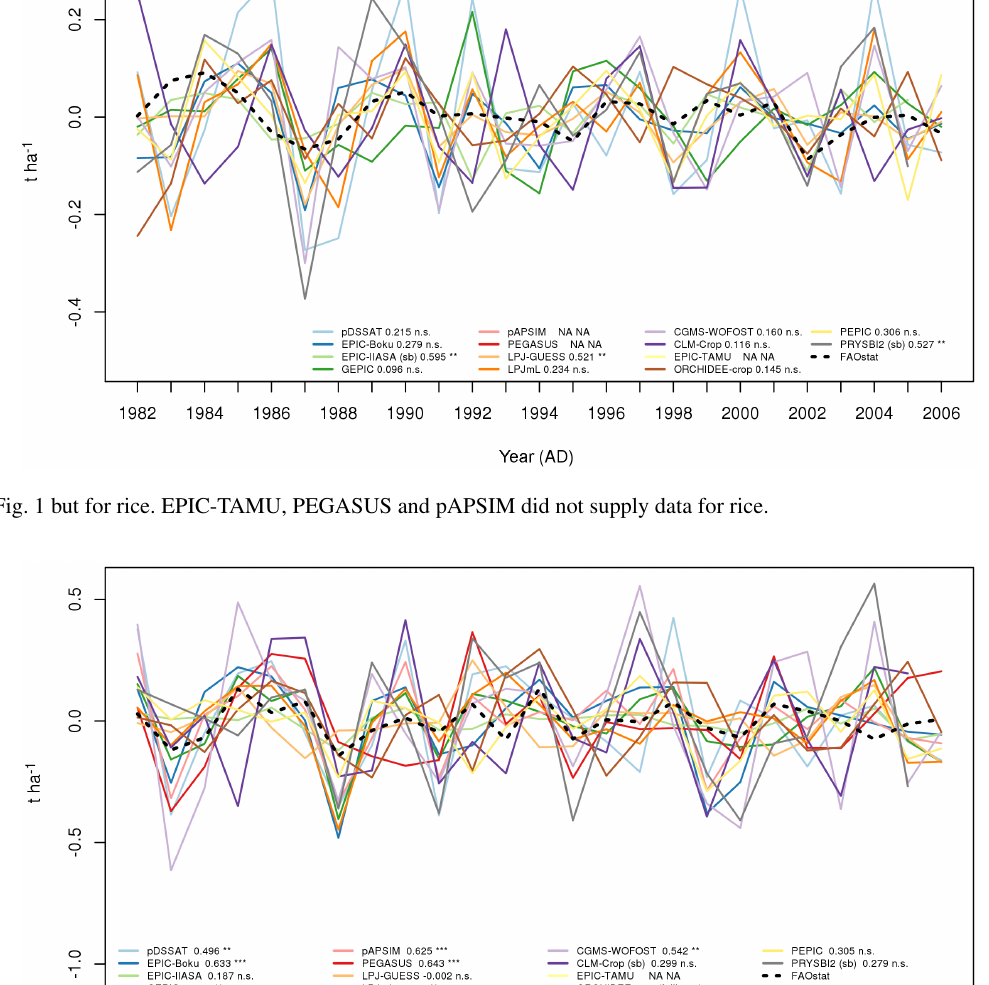
GGCMs. The interannual variability of Indonesia cannot be reproduced well by any of the models (max r is